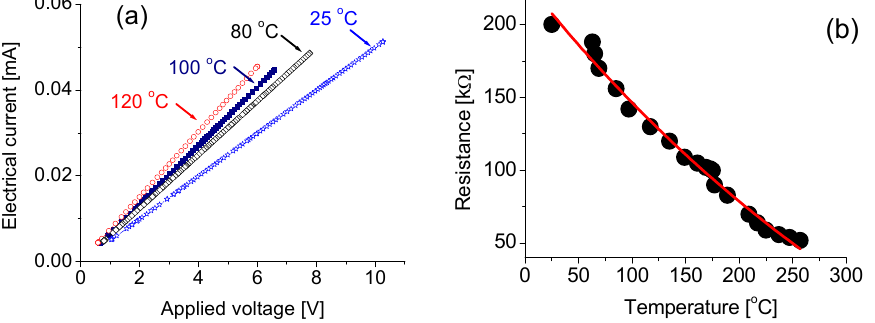
Figure 4. ( a ) Current–voltage (I–V) properties of the DUV ‐ PD at different temperature, ( b ) resistance of active layer as a function of temperature.